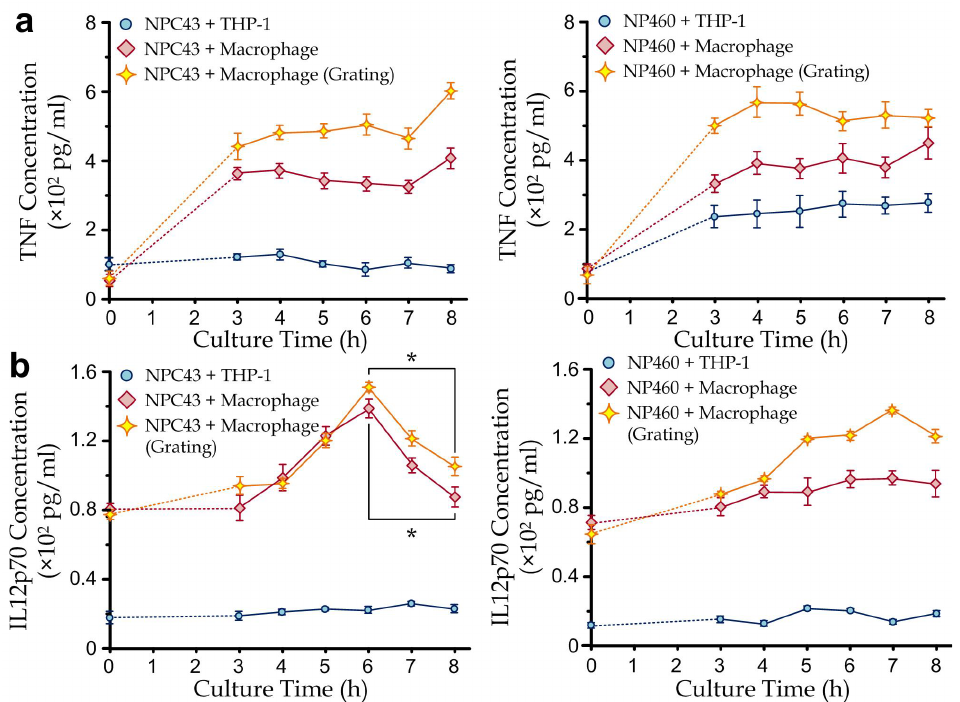
Figure 4. ( a ) The concentration of TNF secreted from cocultured undifferentiated THP-1 and THP- 1-differentiated macrophages with NPC43 cells or NP460 cells, with and without a parallel grating array. ( b ) The concentration of IL-12p70 secreted from THP-1 and macrophages co-cultured with NPC43 cells or NP460 cells, with and without parallel grating array ( n = 4 for each point). Error bars are the standard errors in all plots. Asterisk represents a p -value of <0.05.